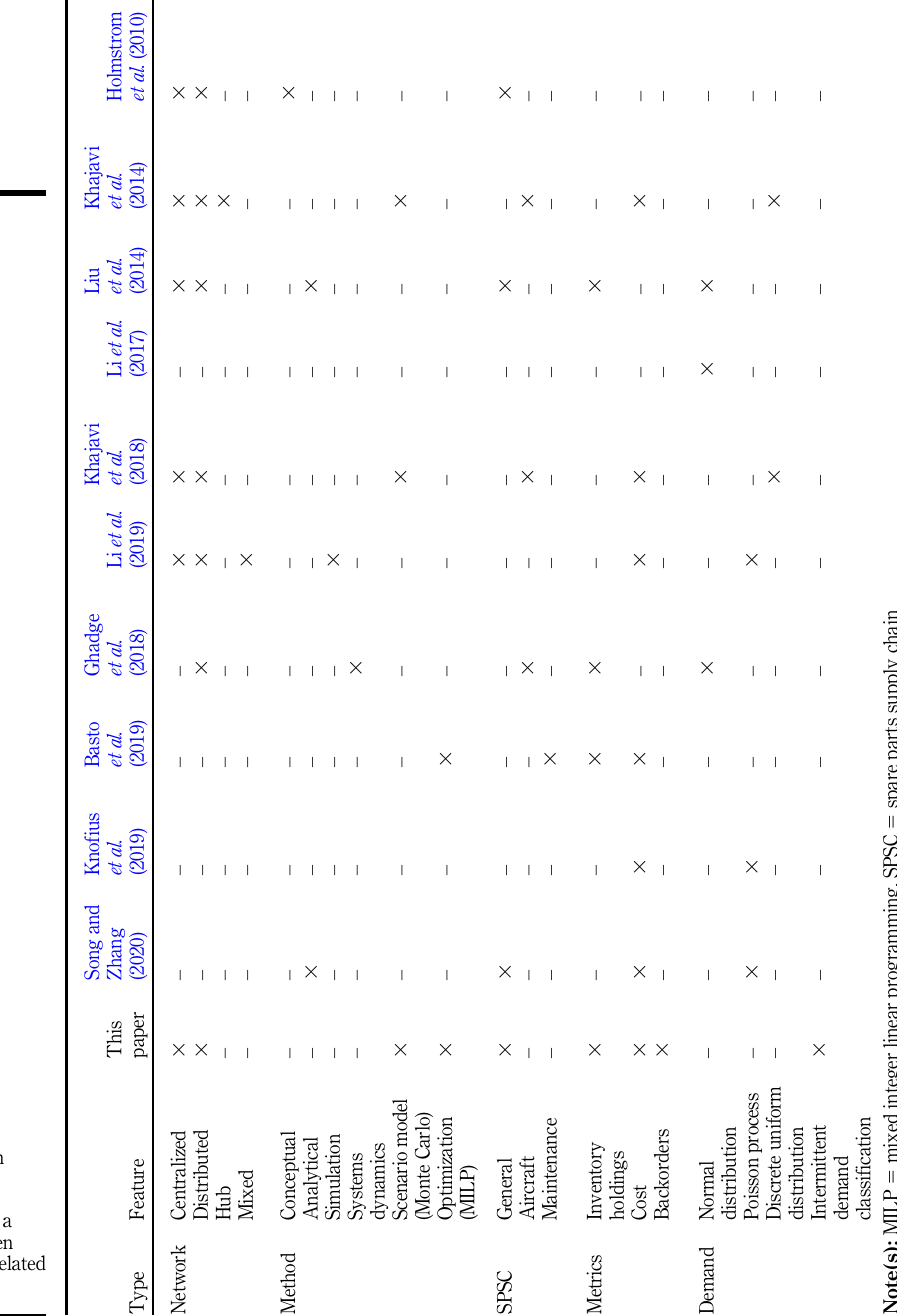
Table 1. Previous research comparing the different configurations of a supply chain when adoptingAMasrelated to this